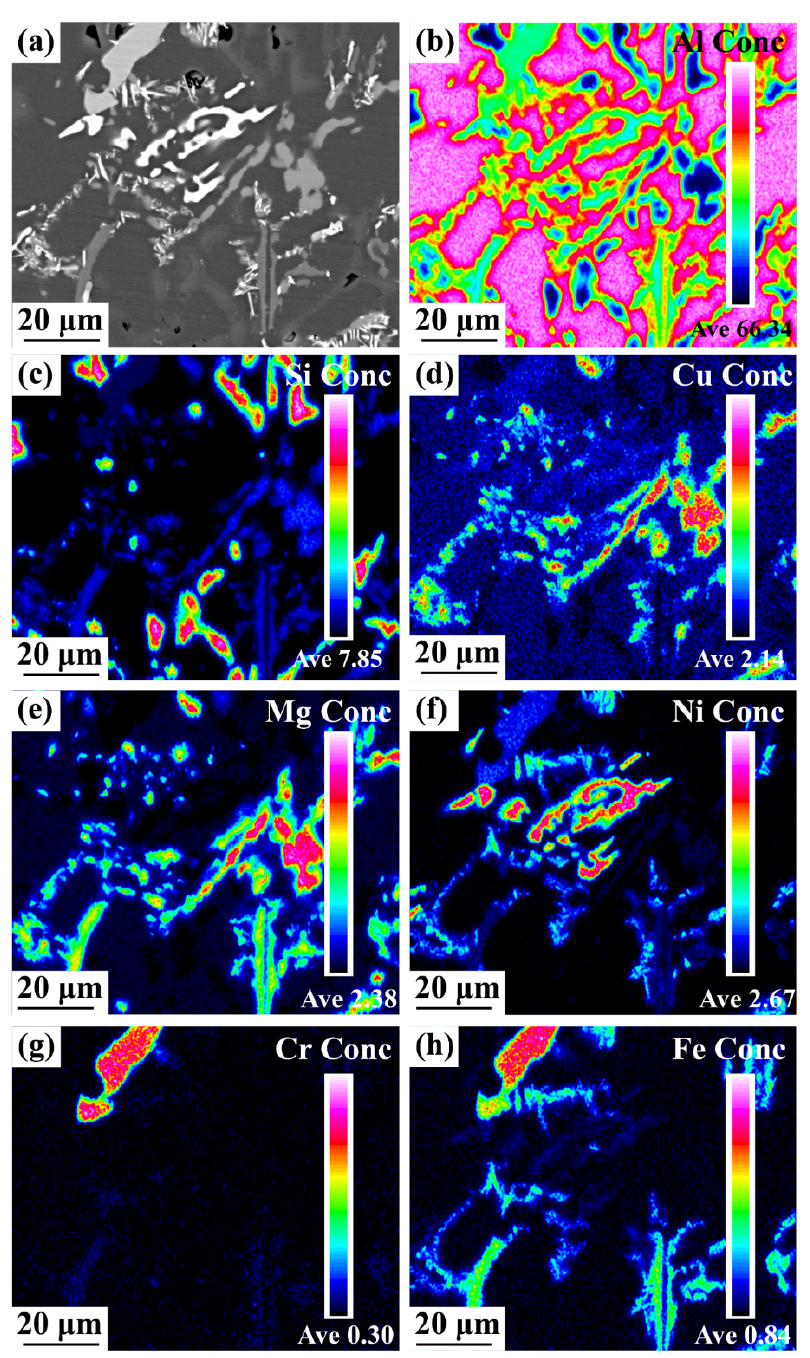
Figure 12. EPMA images and elemental mapping of the T6 state alloy: ( a ) alloy intercept, ( b – h ) elemental